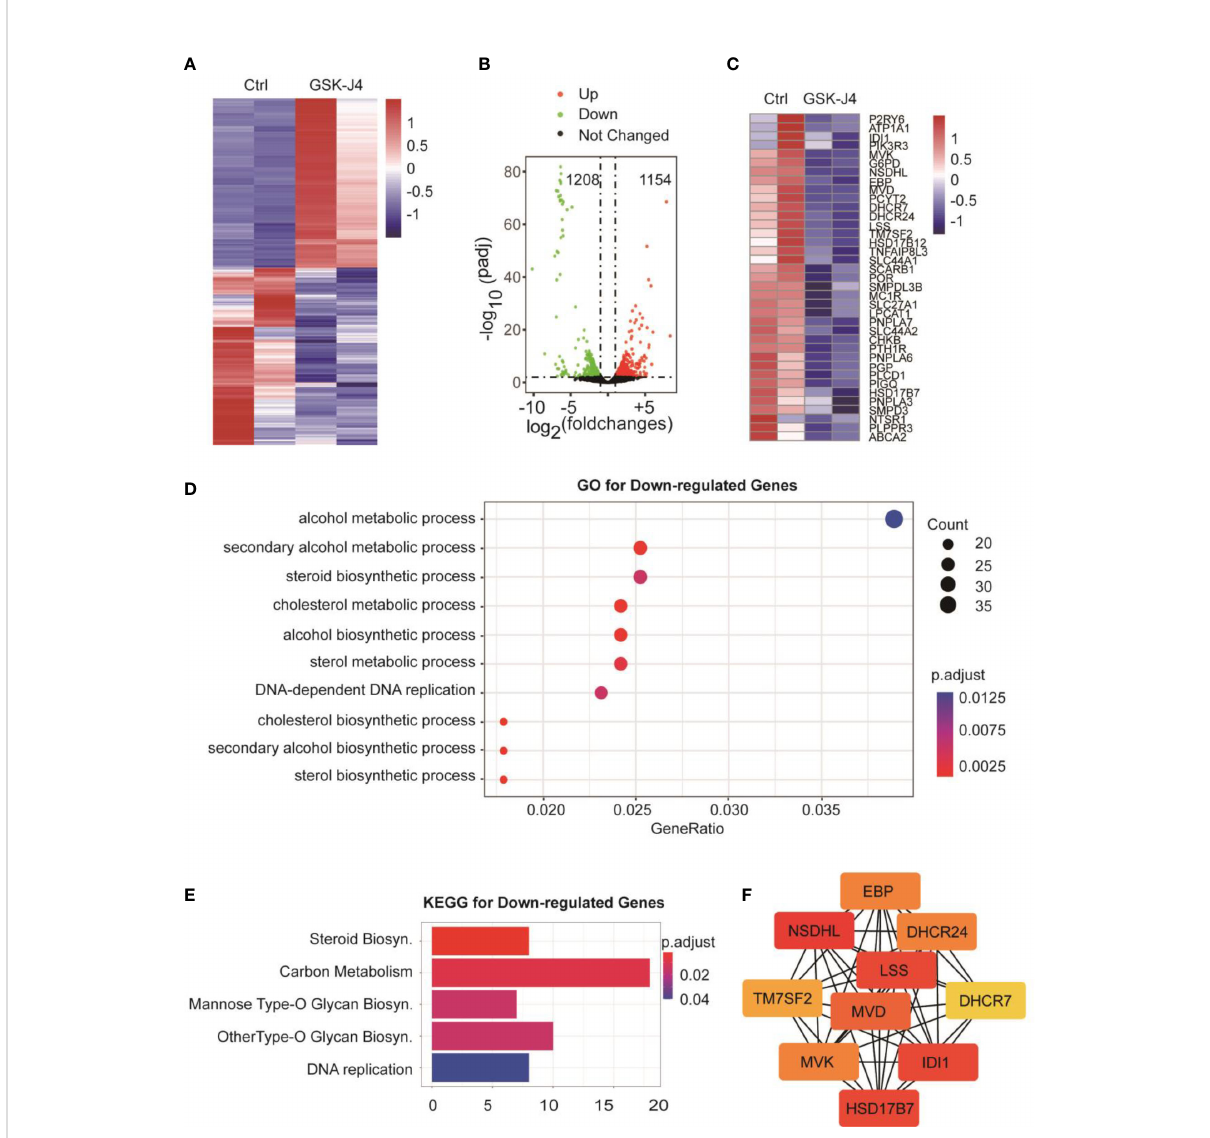
FIGURE 5 Biosynthesis of cholesterol and phospholipids are impaired by GSK-J4 in DaoY cells. (A) Heatmap of gene mRNA levels in DaoY cells after treatment with GSK-J4. (B) Volcano plot of the differentially expressed genes in DaoY cells after treatment with GSK-J4. (C) Heatmap of the mRNA level of cholesterol biosynthesis genes in DaoY cells after treatment with GSK-J4. (D) GO analysis of the down-regulated genes in DaoY cells treated with GSK-J4. (E) KEGG analysis of the down-regulated genes in DaoY cells treated with GSK-J4. (F) STRING analysis for key genes in cholesterol